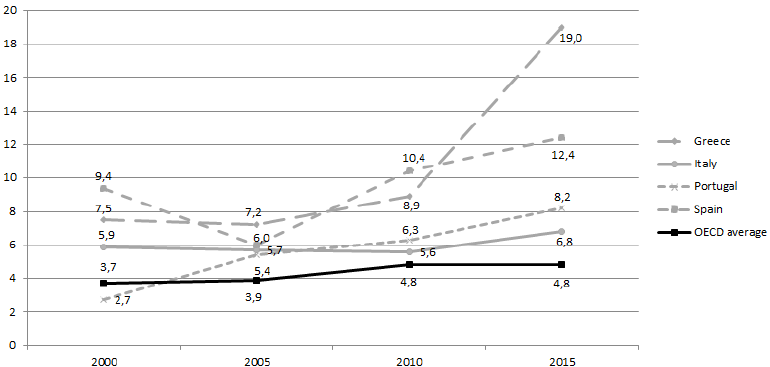
Figure 3: Unemployment rates among population 25-64-years-old population with tertiary education